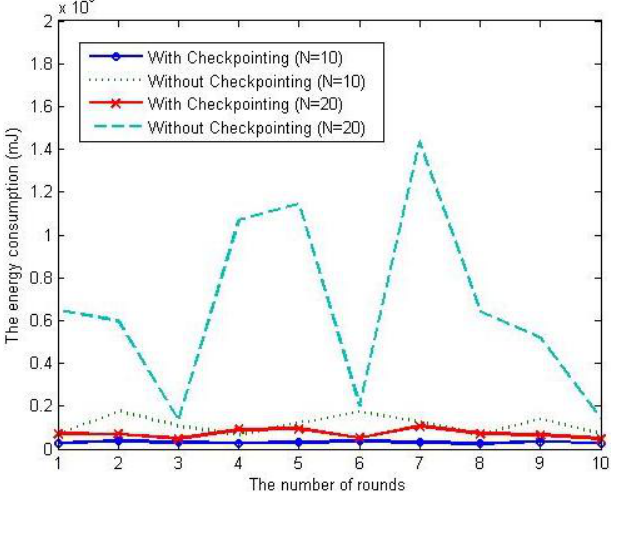
Figure 12. Comparison of the energy consumption values